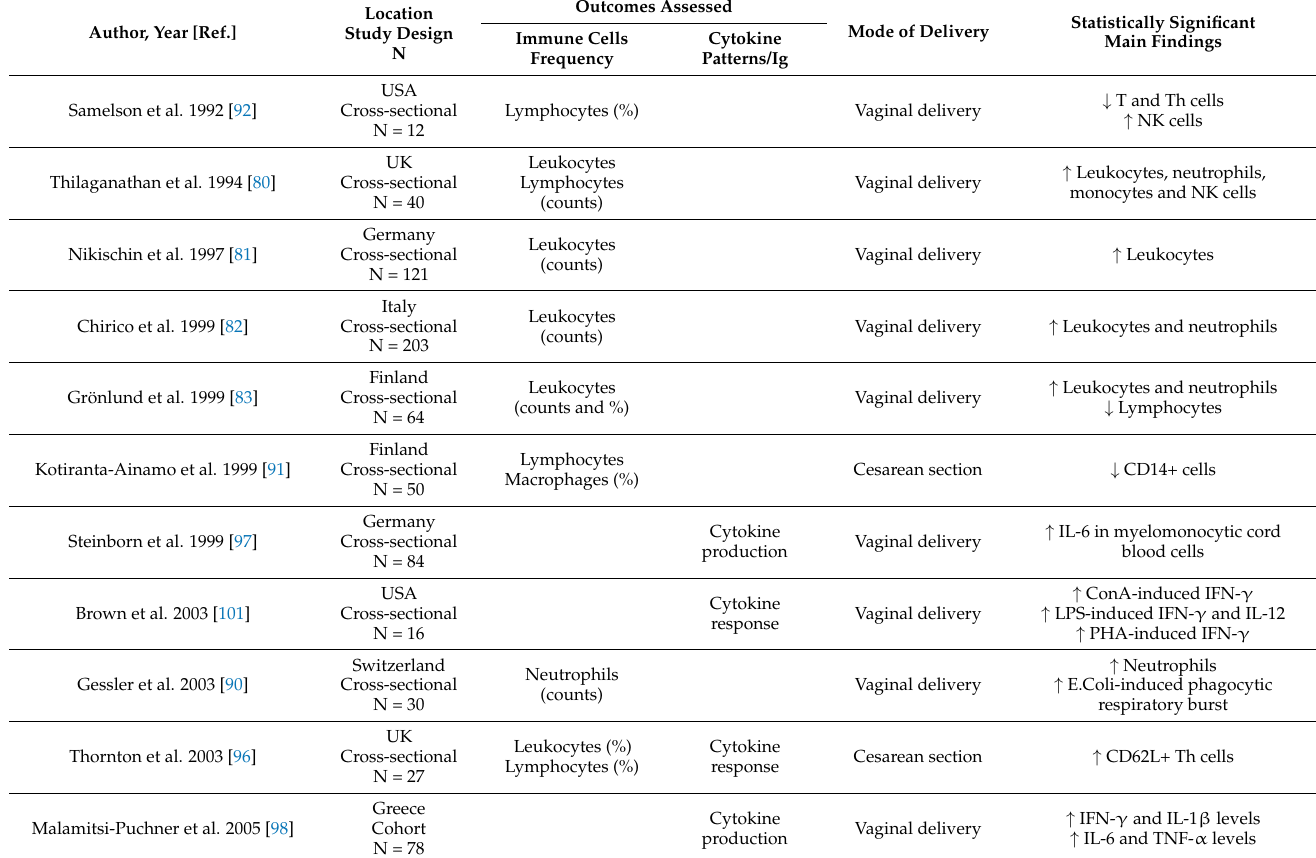
Table 2. Mode of delivery and changes in the immune system of neonates (authors ordered by year and then alphabetically). Author, Year